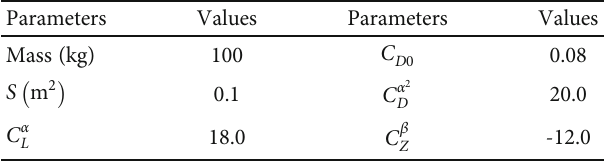
Table 2: Aerodynamic parameters used in simulation.